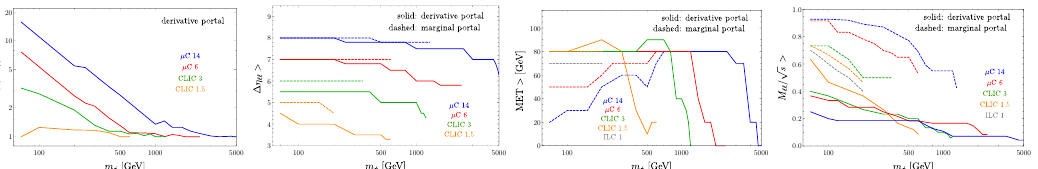
Figure 9: Summary of the cuts we apply at lepton colliders. The cuts not shown here are discussed in the text.